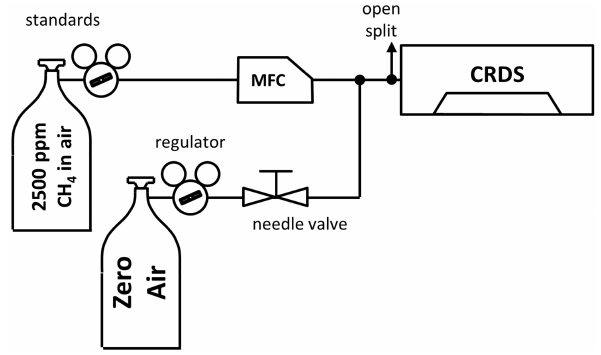
Figure 4. Setup for measuring dilute mixtures of 2500ppm stan- dards. The MFC was set to flows ranging from 2 to 20sccm. The needle valve was set to ∼ 1000sccm dilution, for a concentration range of 2–20ppm delivered to the instrument.